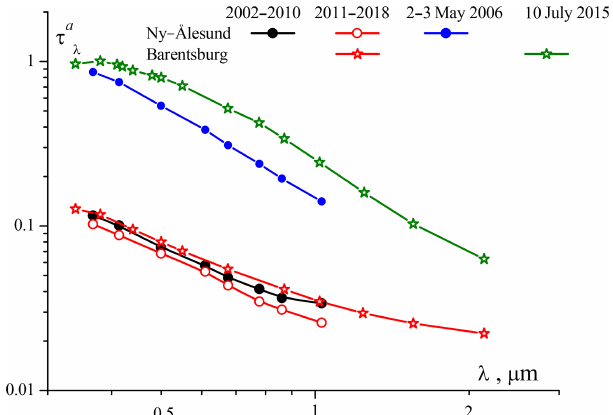
Figure 5. Spectral dependences of AOD: the top of the panel shows situations with high aerosol turbidities of the atmosphere, and the bottom of the panel shows the multiyear averages in the two regions.